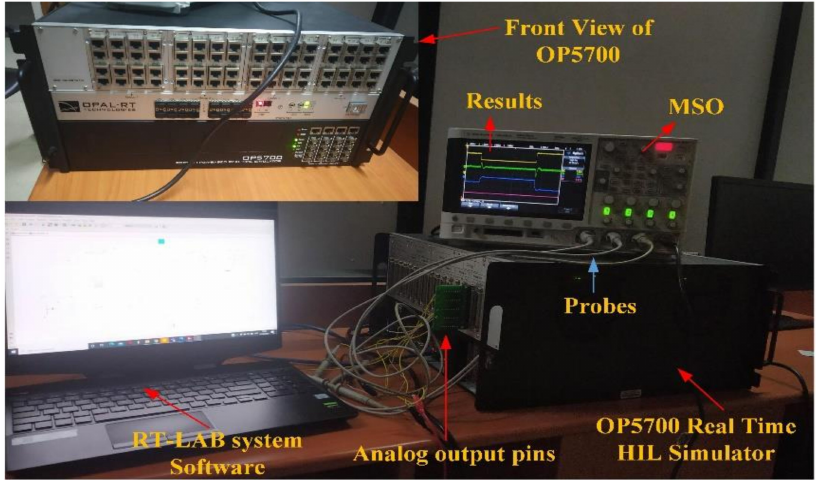
Figure 16. Schematic of OPAL-RT